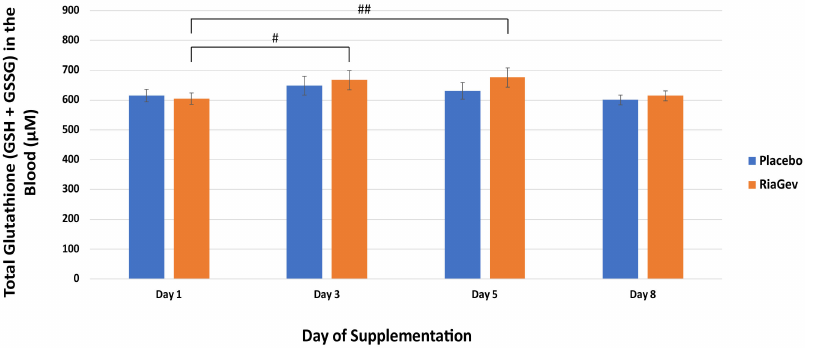
Figure 4. Whole Blood Glutathione (GSH and GSSG) Concentration on Days 1, 3, 5, and 8 of Clinical Trail. The total blood glutathione concentrations are represented as solid bars with standard errors indicated. Significant changes are marked by # ( p < 0.05) or ## ( p <